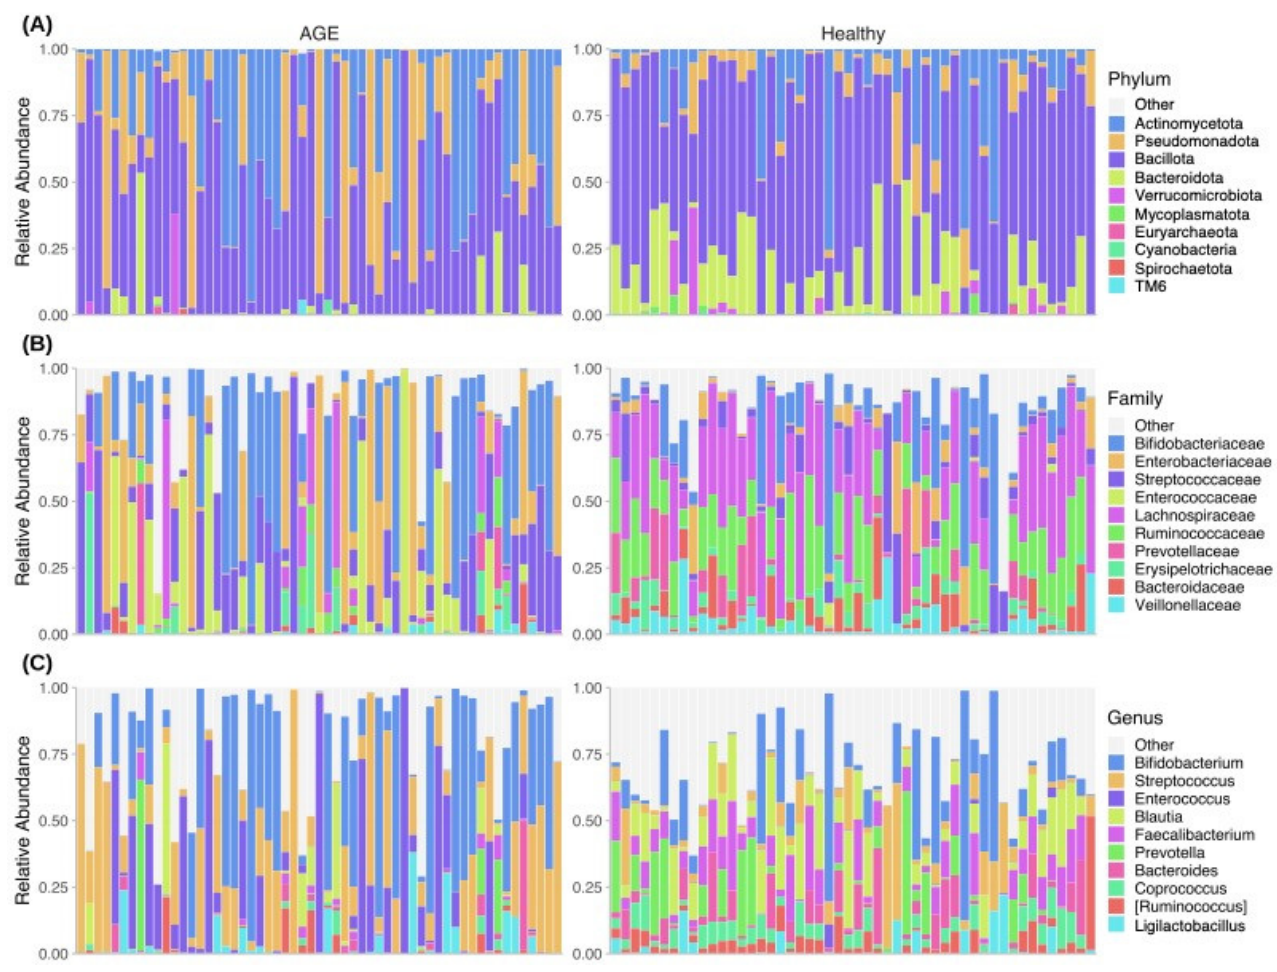
Figure 2. Faecal microbial sequence profiles of AGE cases and healthy controls. Relative abundance of ( A ) Phylum-, ( B ) Family-, and ( C ) Genus-level features. Samples are grouped according to status (AGE cases or healthy controls). Each bar represents an individual faecal microbial sequence profile. Top 10 most dominant taxa are shown, with the remaining collapsed under